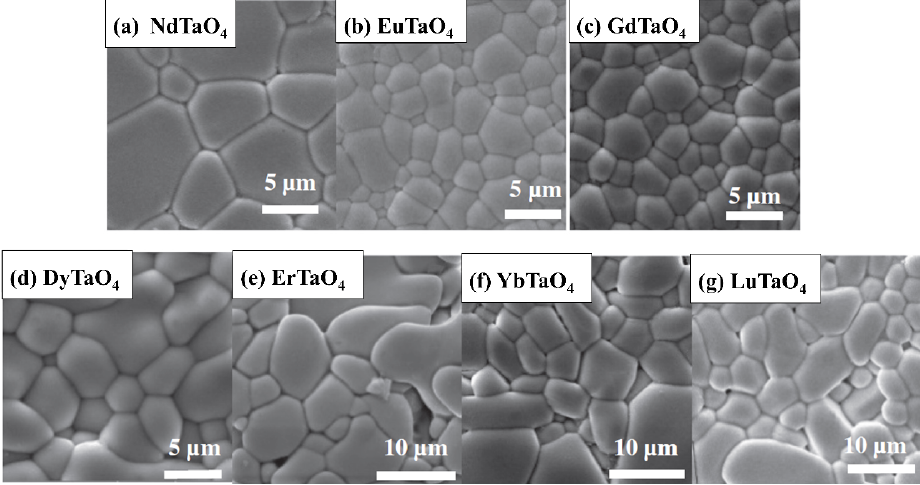
Fig. 13 SEM photographs of RETaO 4 (RE = Nd, Eu, Gd, Dy, Er, Yb, and Lu) ceramics. (a) NdTaO 4 , (b) EuTaO 4 , (c) GdTaO 4 ,